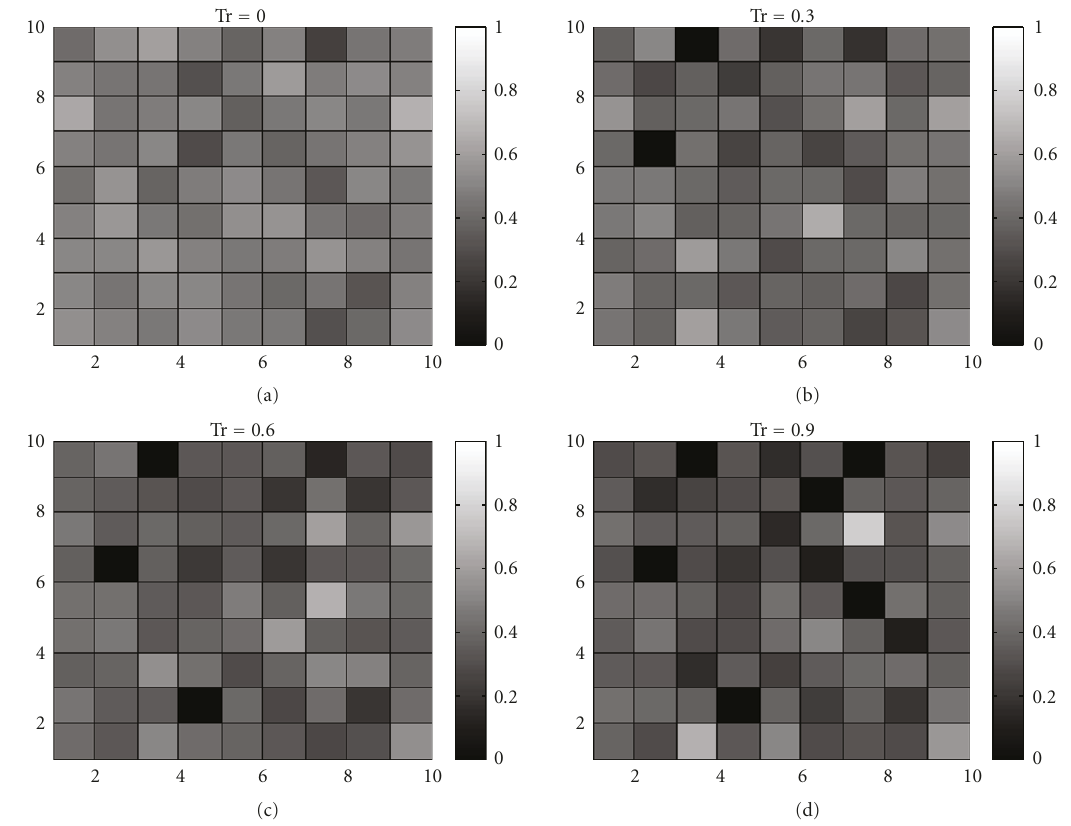
Figure 20: 3D illustration of spatial distribution of clustering coe ffi cient across the graph: dataset B.